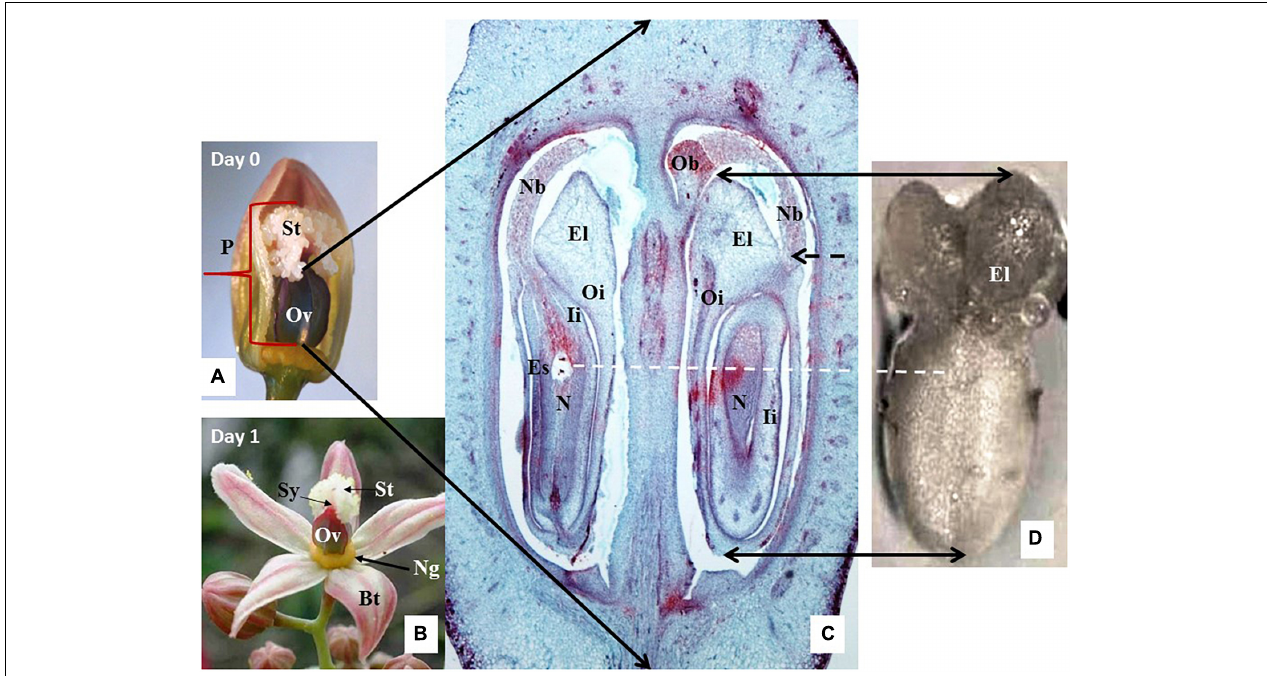
FIGURE 1 | Anatomy and histology of cassava female cyathium. (A) A cyathium with two out of five bracts removed to expose its pistil (P) with large ovary (Ov) and feathery white stigma (St). Material collected just before bract opening, on the day considered as the day of anthesis (Day 0). (B) Cyathium collected the next day after the bracts (Bt) opened, i.e., the first day after anthesis (1 DAA). The female cyathium of cassava is reduced to a single pistil (P) and circle of yellow nectar glands (Ng) just below the ovary (Ov). The short style (Sy) neck is hardly visible under the white feathery stigma forming three lobes. (C) A cross-longitudinal section of the ovary as indicated by the black arrows. Two out of three ovules are visible, sectioned at different angles. One ovule is present per loculus. Outer integuments (Oi) form large elaiosomes (El), also called caruncles, are visible as well as in (D). Inner integuments (Ii) form a thick layer around the nucellus (N). The nucellus protrudes through the micropyle with a long nucellar beak (Nb), whose end tightly touches an obturator (Ob) (more visible on the top end of the right loculus). The position of the embryo sac (Es) is visible in the ovule of the left loculus. (D) A dissected ovule, isolated for culture and observed from the abaxial side. The adaxial side of the ovule is placed on the solid-culture medium. Black-dashed arrow shows the site where the beak, now broken, should appear. White-dashed line marks the most probable position of the embryo sac in the dissected